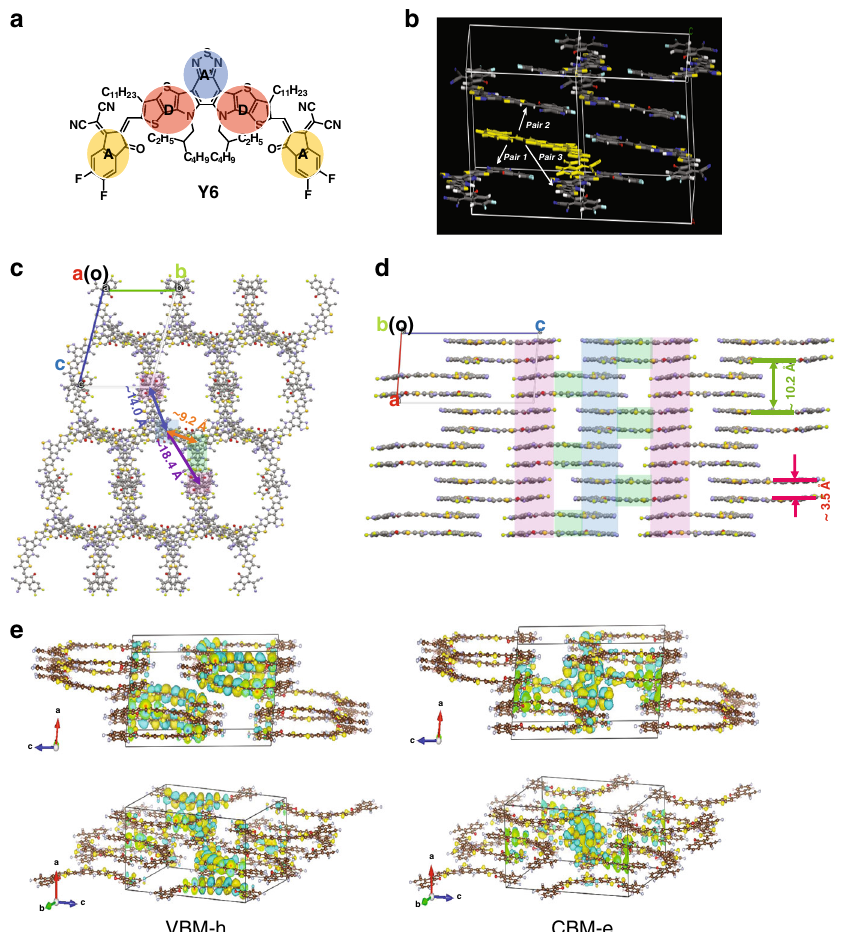
Fig. 1 Molecular and single-crystal structures, and wavefunction distribution of Y6. a – e Molecular structure of Y6 ( a ). b Molecular pairs in the Y6 single crystal. c Top and d side views of the extended-crystal structure (the blue column is the stack of end groups in the b direction, the pink column is the stack of end groups in the c direction, and the green one is a molecular packing pair of D – A ′ fragment). e Calculated valence band maximum (VBM) for hole (left) and conduction band minimum (CBM) for electron (right) wavefunctions at the Γ point (center of the Brillouin zone) in the Y6 single